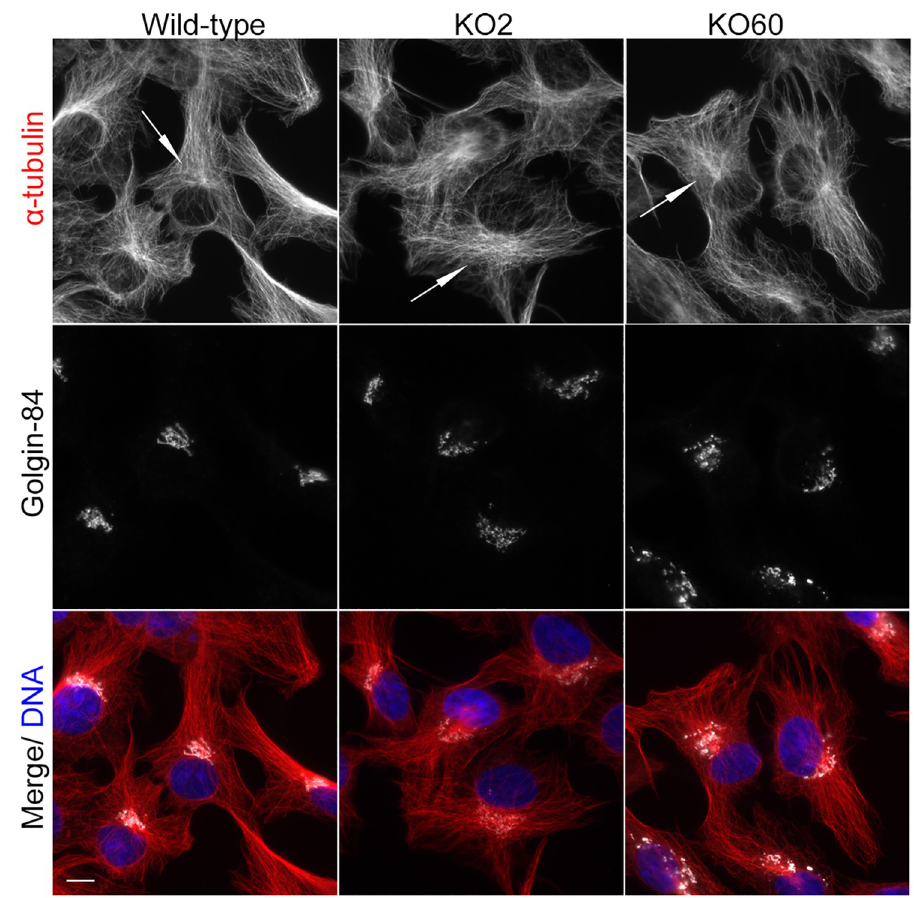
Fig 2. GM130 is not necessary for microtubule organization. Wild-type and GM130 KO cells were stained with antibodies to α -tubulin and Golgin-84 to visualize microtubule organization and Golgi structure, respectively. Merged images in which DNA is stained with DAPI are also shown. The arrows highlight the perinuclear region of these cells. Scale bar, 10 μ M.